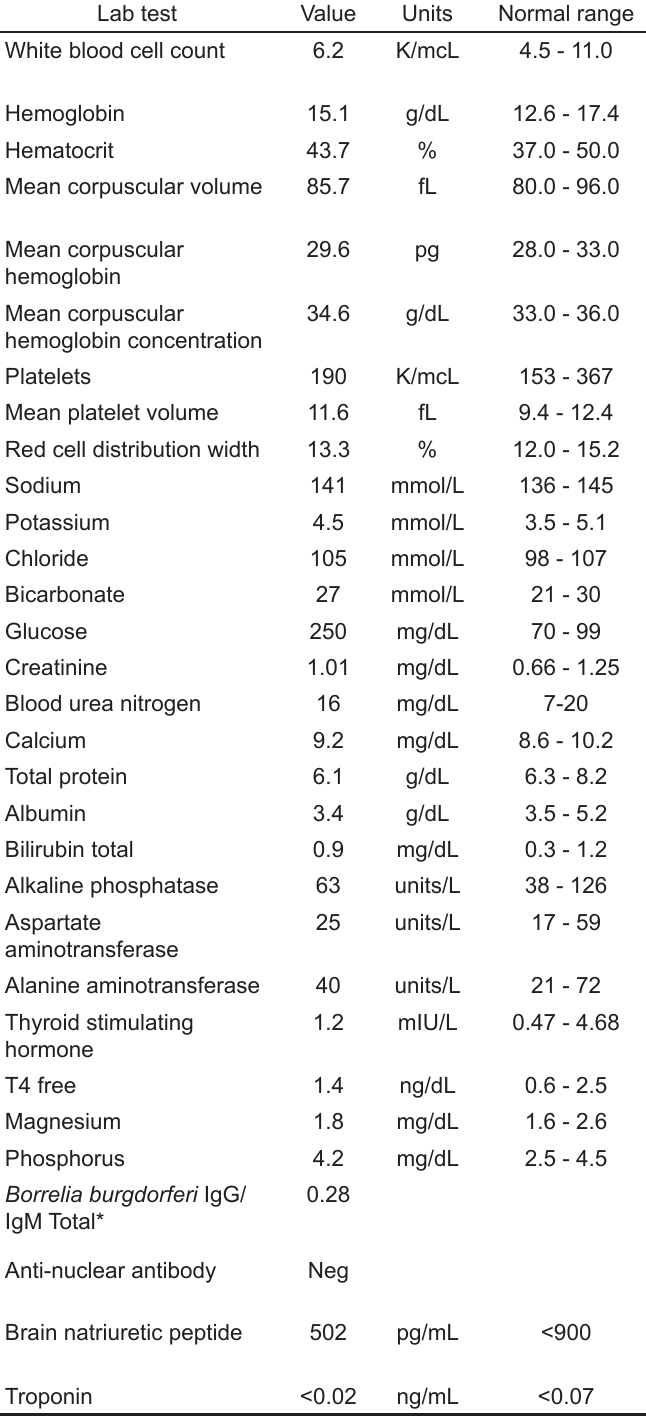
Table. Laboratory results of a 55 year-old male with palpitations and